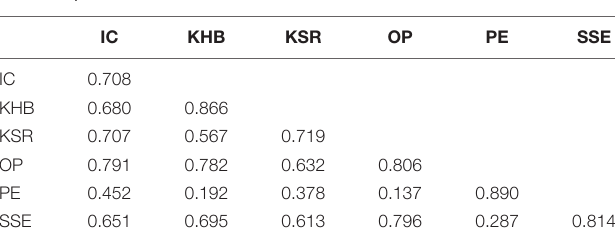
TABLE 4 | Fornell and Larcker